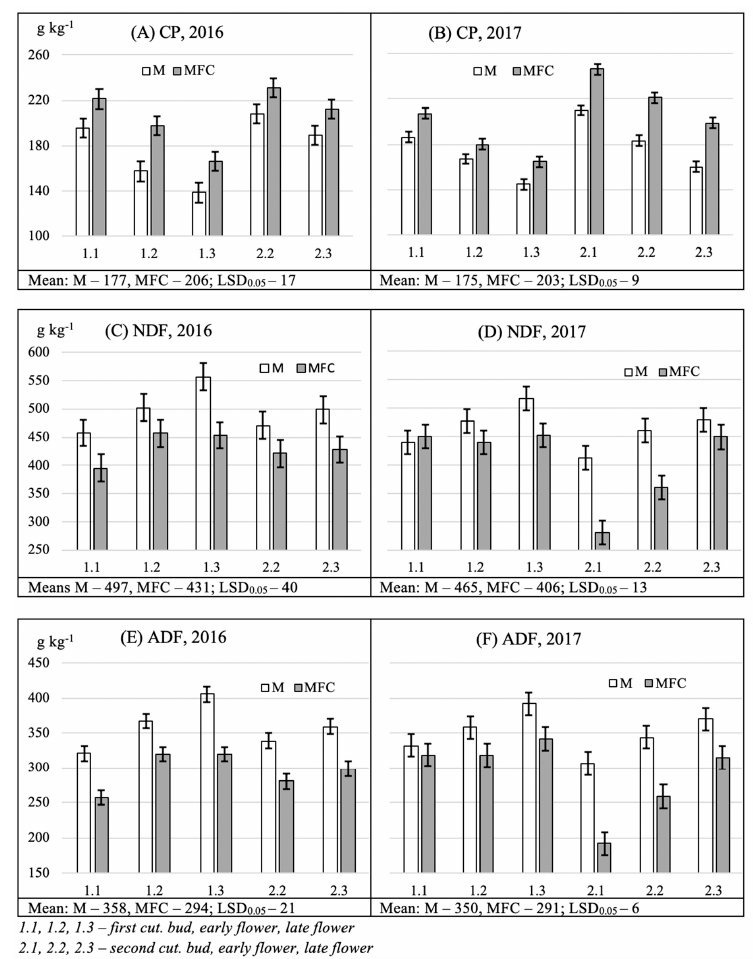
Figure 1. ( A , B ) Crude protein (CP), ( C , D ) neutral deteegent fiber (NDF), ( E , F ) acid detergent fiber (ADF) concentration of alfalfa harvested whith a sickle-bar mower (M) or modified flail chopper (MFC) dependent on cut and plant development stage. The bars indicate LSD ( p = 0.05) values for comparing means across harvest methods and events ( A , B , E ) or between harvest methods within harvest event ( C , D , F ) where harvest method X harvest event interaction was detected. The NDF concentration of alfalfa harvested using an MFC was 66 g kg